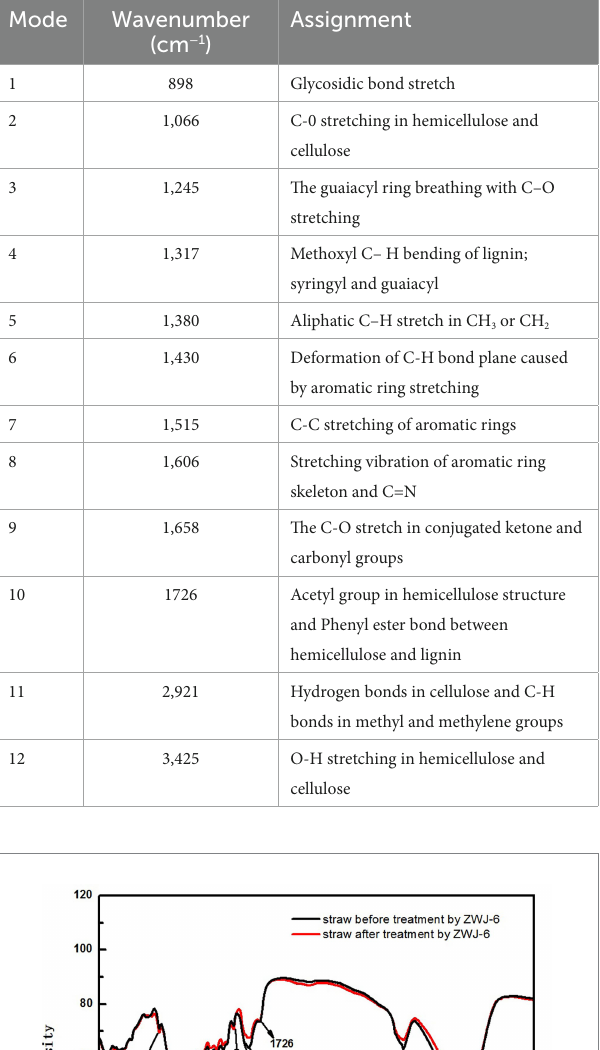
TABLE 1 Assignment of wavenumber value in the infrared absorption spectra of straw before and after treatment by ZJW-6.